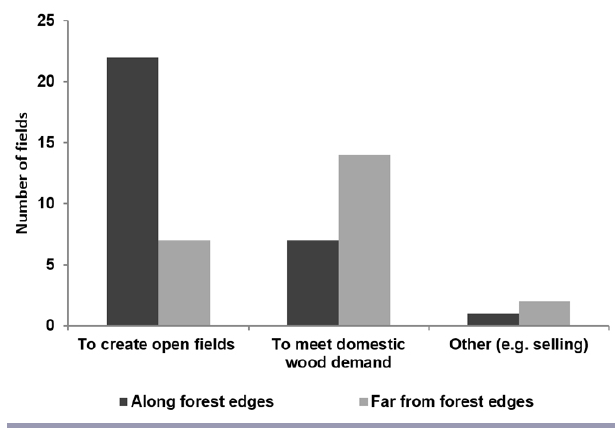
Fig. 7 . Major reasons reported by farmers for removing trees in agricultural fields over the past 5 to 10 years. The numbers of fields were pooled data (frequency) for villages close to and away from forest edges, separately.